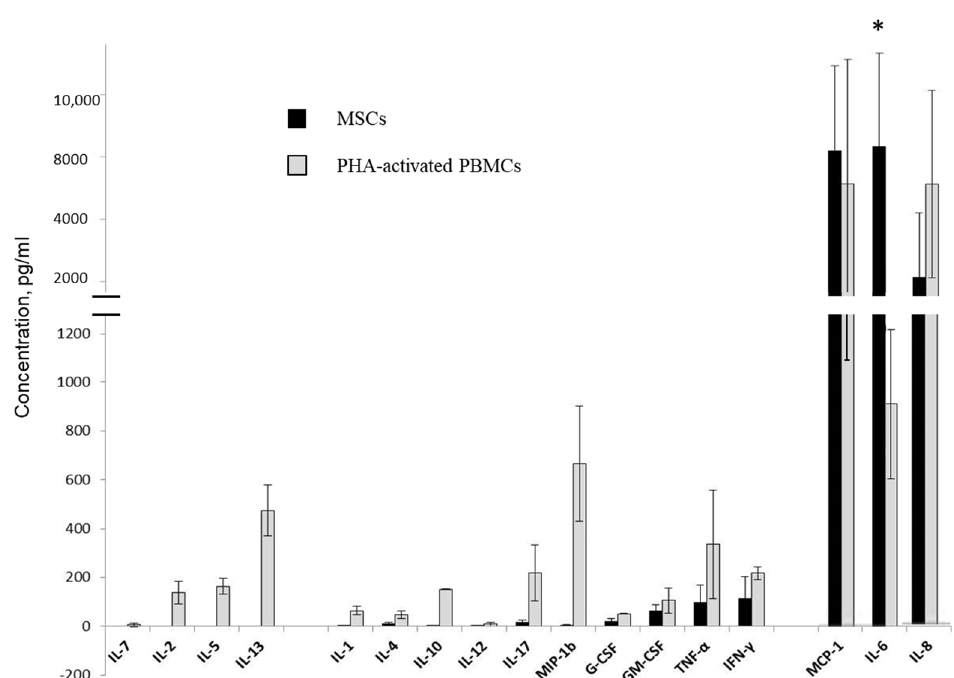
Figure 4. Evaluation of human cytokine concentration in conditioned medium of MSCs and PHA- activated PBMCs, determined via multiplexed fluorescent bead-based immunoassay detection. Three unrelated donors per cell type were used. Data are shown as mean ± std; t -test, * reliability of differences at p <